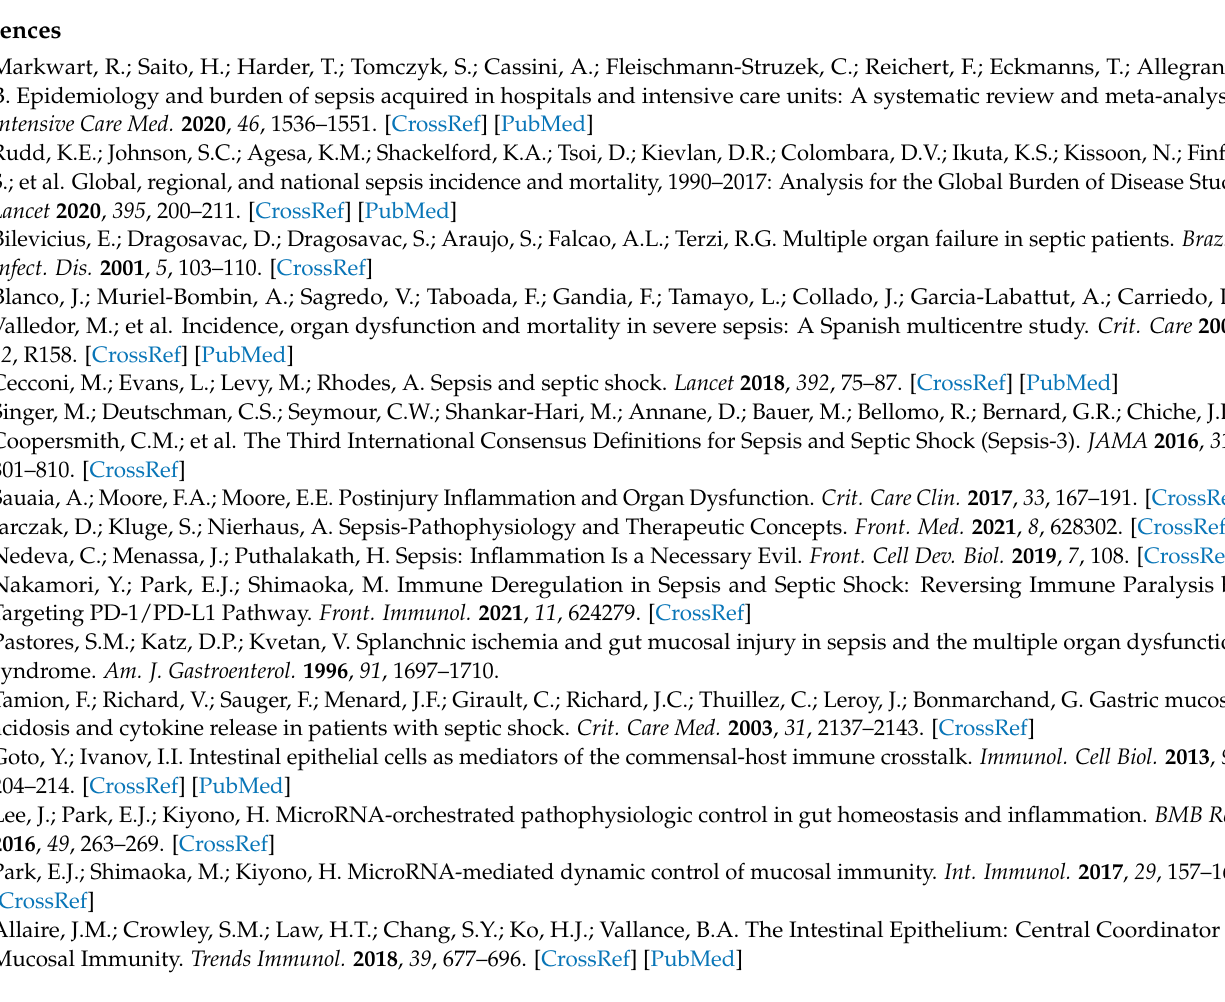
in IECs. Table S2. Primer sequences for RT-qPCR used in this study. Table S3. Reactome pathways detected in IECs with sepsis, hit numbers, and p values. Table S4. GO pathways detected in IECs with sepsis, hit numbers, and p values. Table S5. KEGG pathways detected in IECs with sepsis, hit numbers, and p